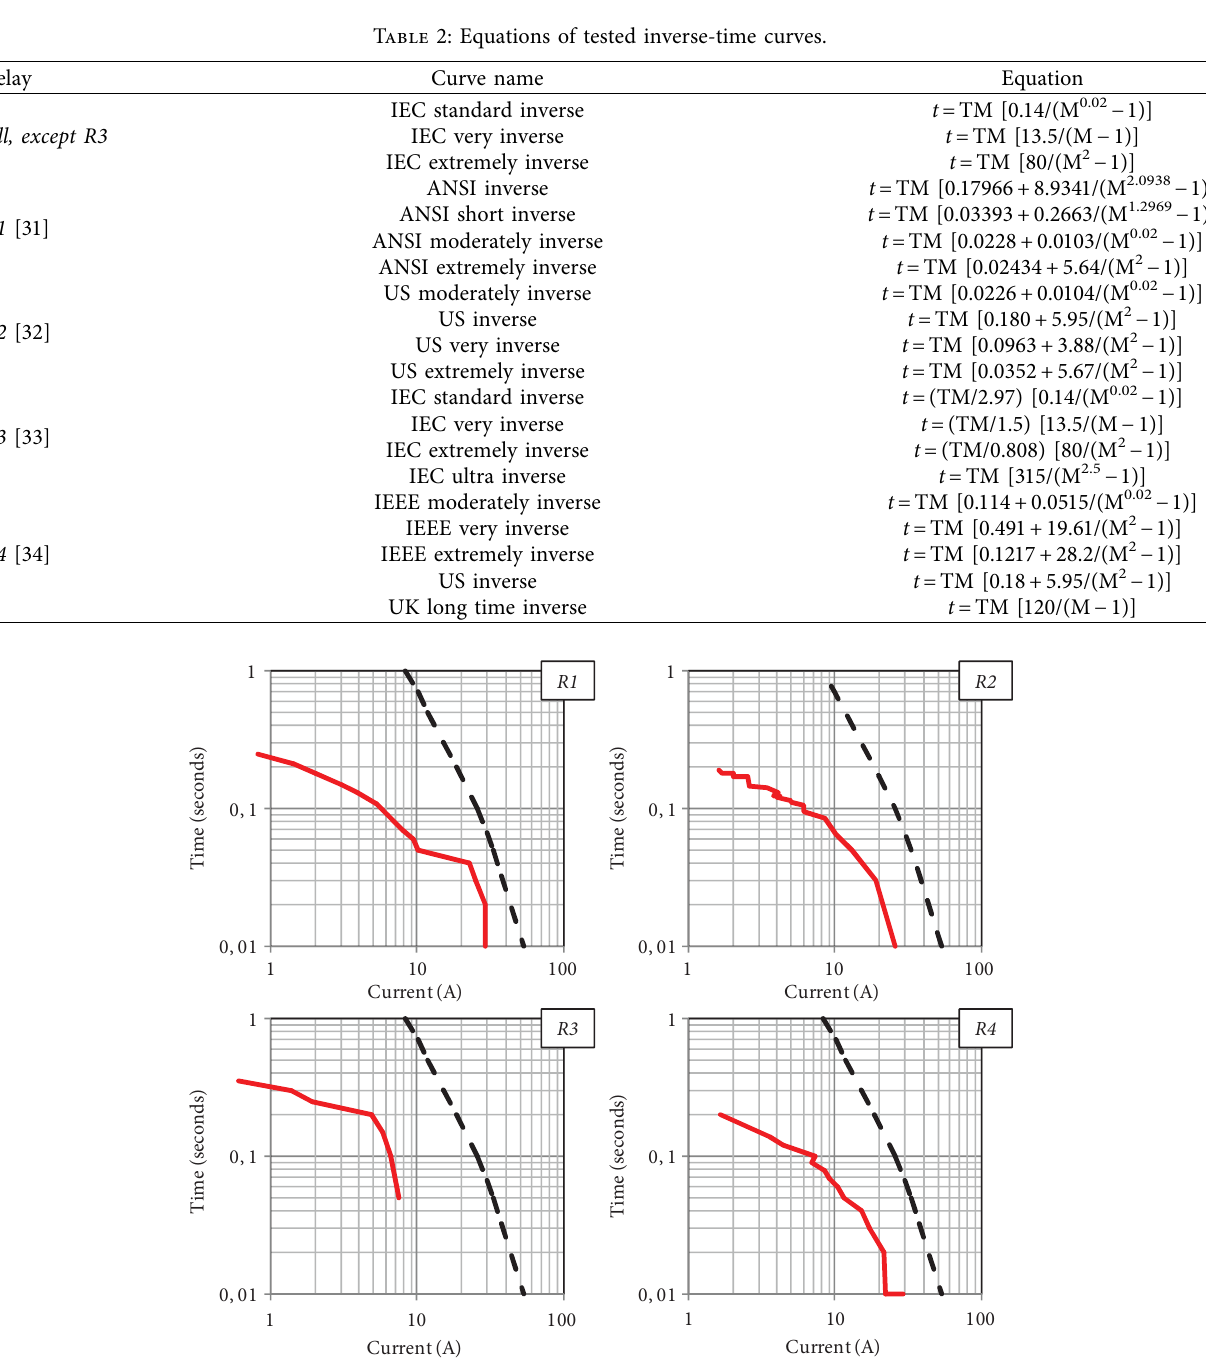
Figure 4: Results for instantaneous and defnite-time functions. Te dashed line is the cumulative RMS value of test